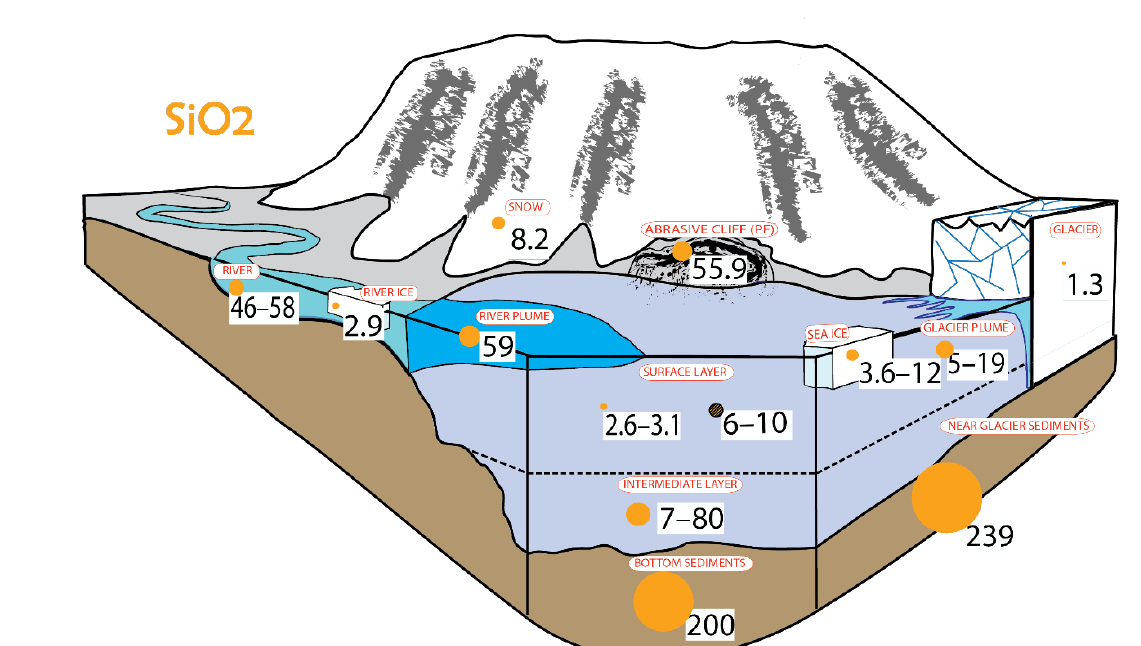
Figure 7. Content of phosphate ( A ), silicate ( B ), and nitrate ( C ) in the following environmental media: seawater, bottom sediment, river water, sea ice, river ice, glacier ice, snow, and abrasive cliff (permafrost). For the seawater, we saw concentrations in the surface layer in the outer fjord, in the surface layer near the glacier influenced by the glacial plume, in the river plume, and in the intermediate layer. Concentrations or ranges of concentrations are given in μM. Circles show relative change of concentrations; the dashed circle corresponds to the winter (only in the surface water).